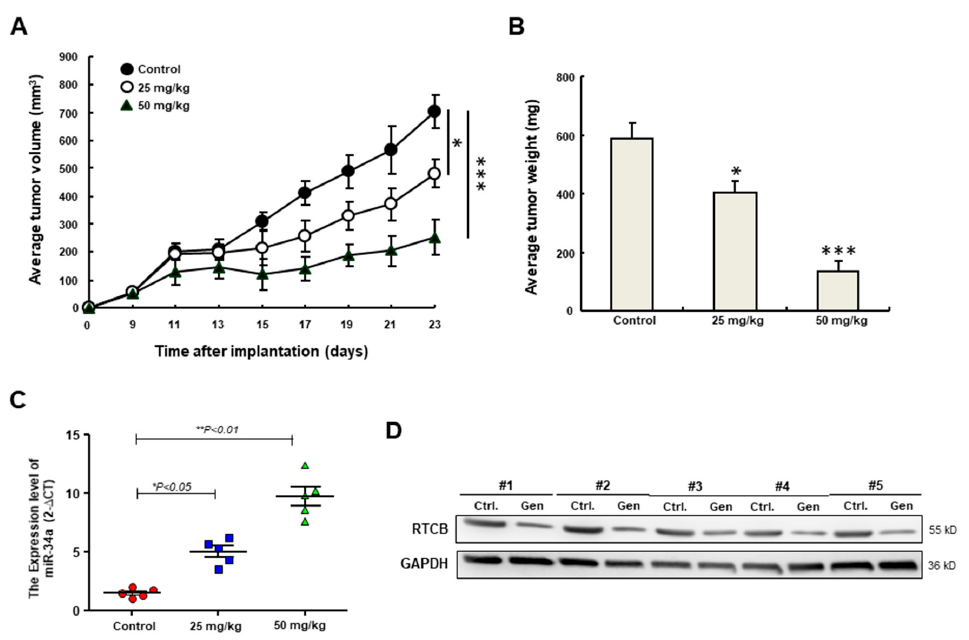
Figure 7. ( A ) Tumor volume and ( B ) tumor weight of subcutaneous HNC-TICs xenografts in nude mice treated with the indicated concentration of genistein (Gen); ( C ) The relative gene expression of miR-34a and ( D ) the protein expression of RTCB (RNA 2',3'-cyclic phosphate and 5'-OH ligase) in the excised tumors. GAPDH (glyceraldehyde-3-phosphate dehydrogenase) was used as the internal control. * p < 0.05; *** p < 0.01